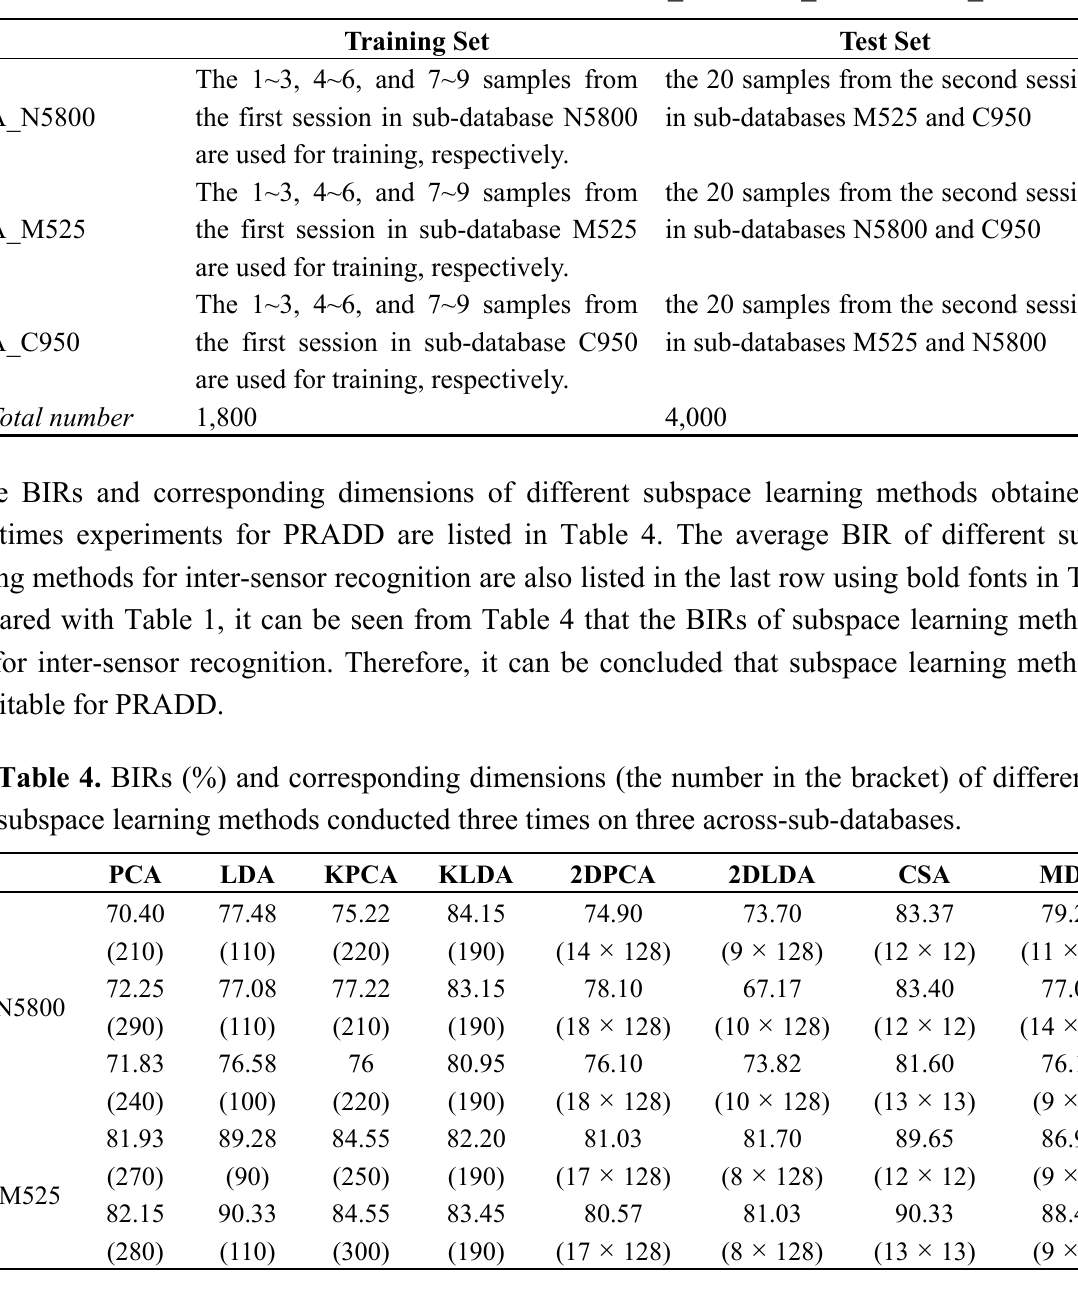
Table 3. The details of three across-sub-databases, A_N5800, A_M525 and A_C 950.